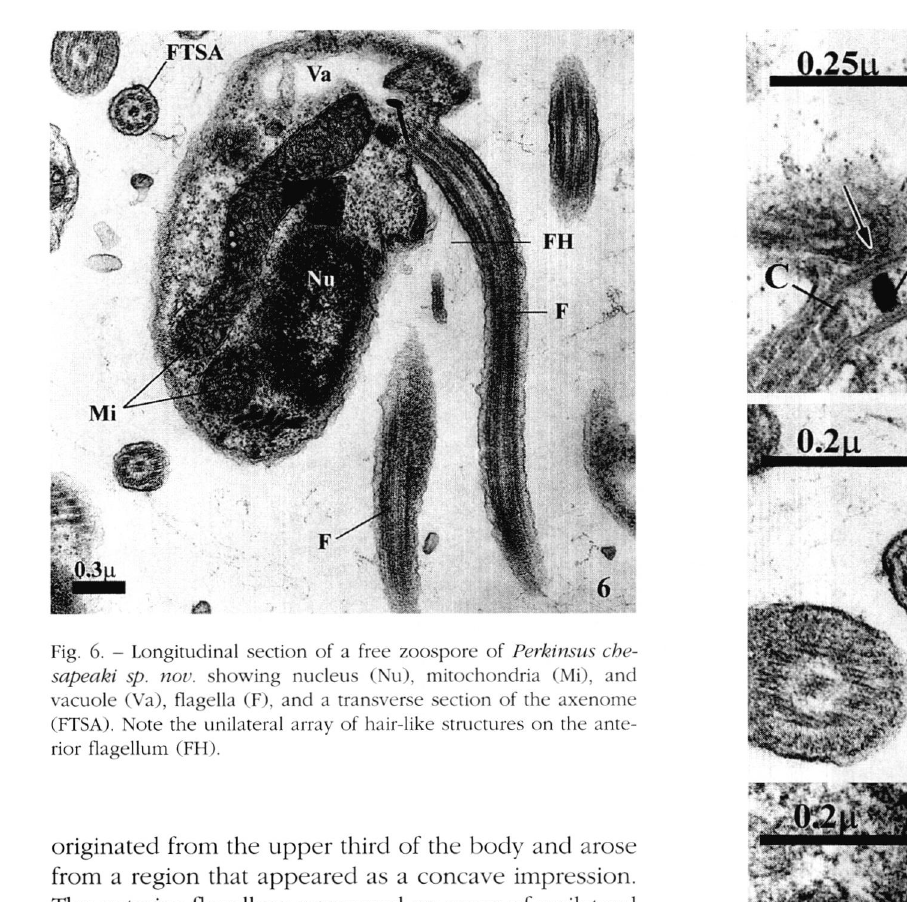
Fig. 6. - Longitudinal section of a free zoospore of Perkinsus che- sapeaki sp. nor. showing nucleus (Nu), mitochondria (Mi), and vacuole (Va), flagella (F), and a transverse section of the axenome (FTSA). Note the unilateral array of hair-like structures on the ante­ rior flagellum (FH).